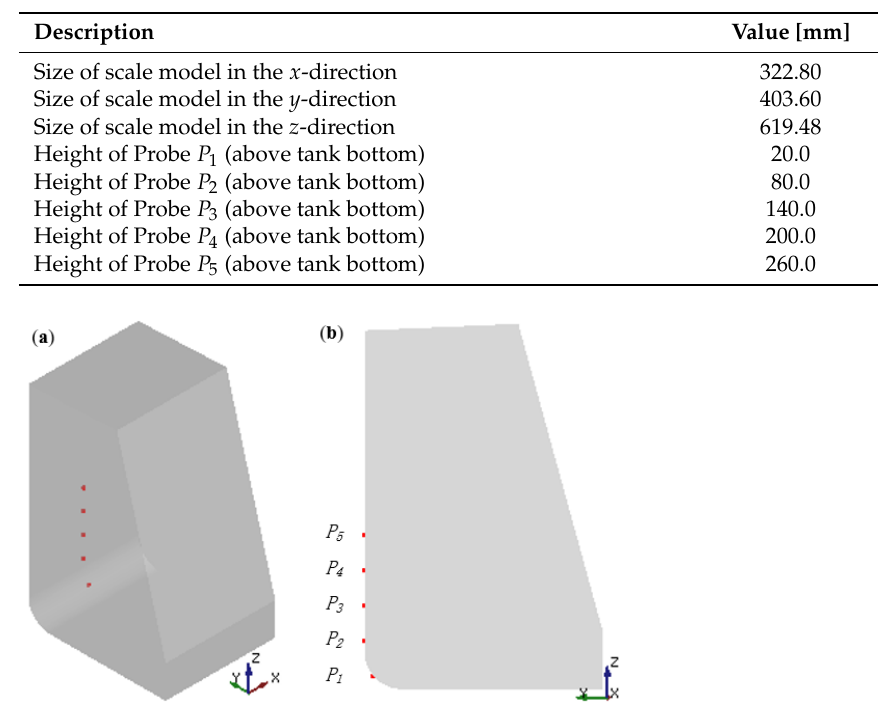
Figure 6. Illustration of the particular points on “R2.03AP”. ( a ) custom view; ( b ) lateral